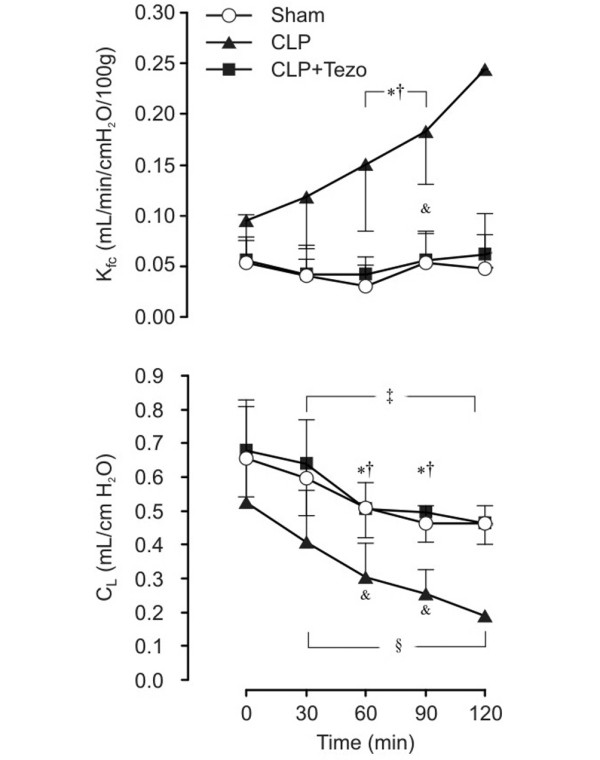
Microvascular filtration coefficient (Kfc) and compliance (CL) in lungs isolated 12 h after surgical interventions. Data are presented as mean ± SEM. Sham, sham-operated group (n = 5); CLP, cecum ligation and puncture group (n = 7); CLP+Tezo, cecum ligation and punction + tezosentan group (n = 7). *p < 0.05 between CLP and CLP+Tezo groups; † p < 0.05 between Sham and CLP groups; ‡ p < 0.05 from t = 0 minutes in Sham group; &p < 0.05 from t = 0 minutes in the CLP group; §p < 0.05 from t = 0 minutes in the CLP+Tezo group.